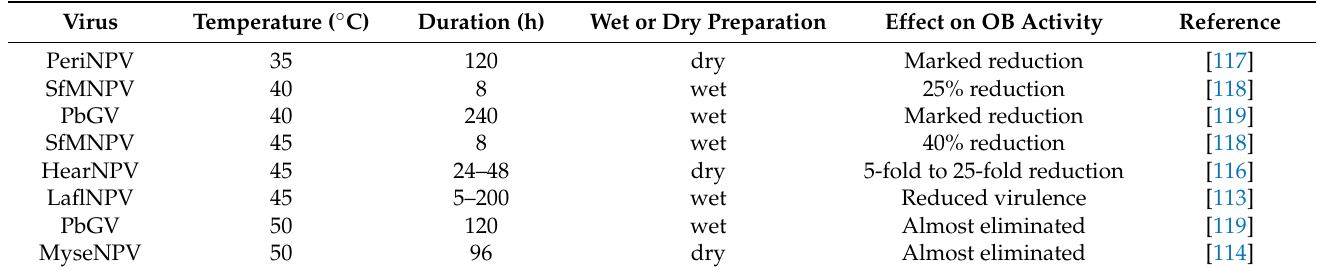
Table 4. Thermal stability of wet and dry laboratory preparations of OBs in the range 35–50 ◦ C likely to be experienced by OBs at the soil